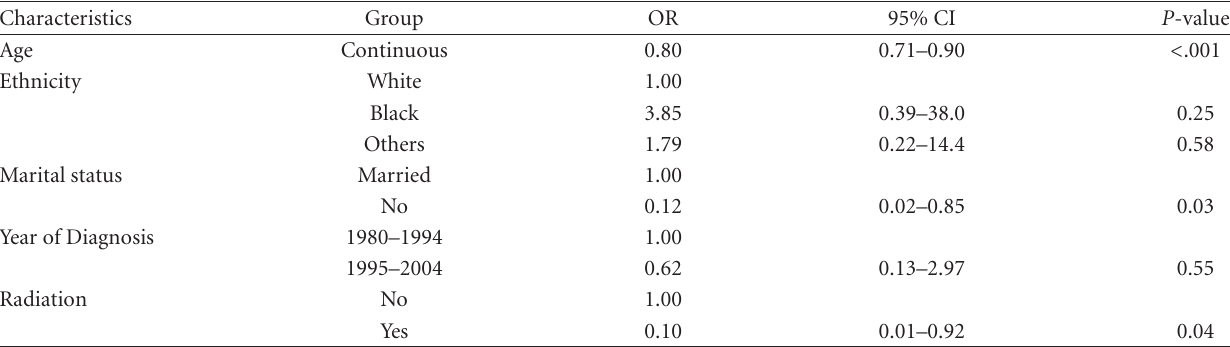
Table 3: Multivariate Analyses of Factors Associated with Receipt of Radical Prostatectomy in Patients with Localized/Regional Stage Signet Ring Prostate Carcinoma.